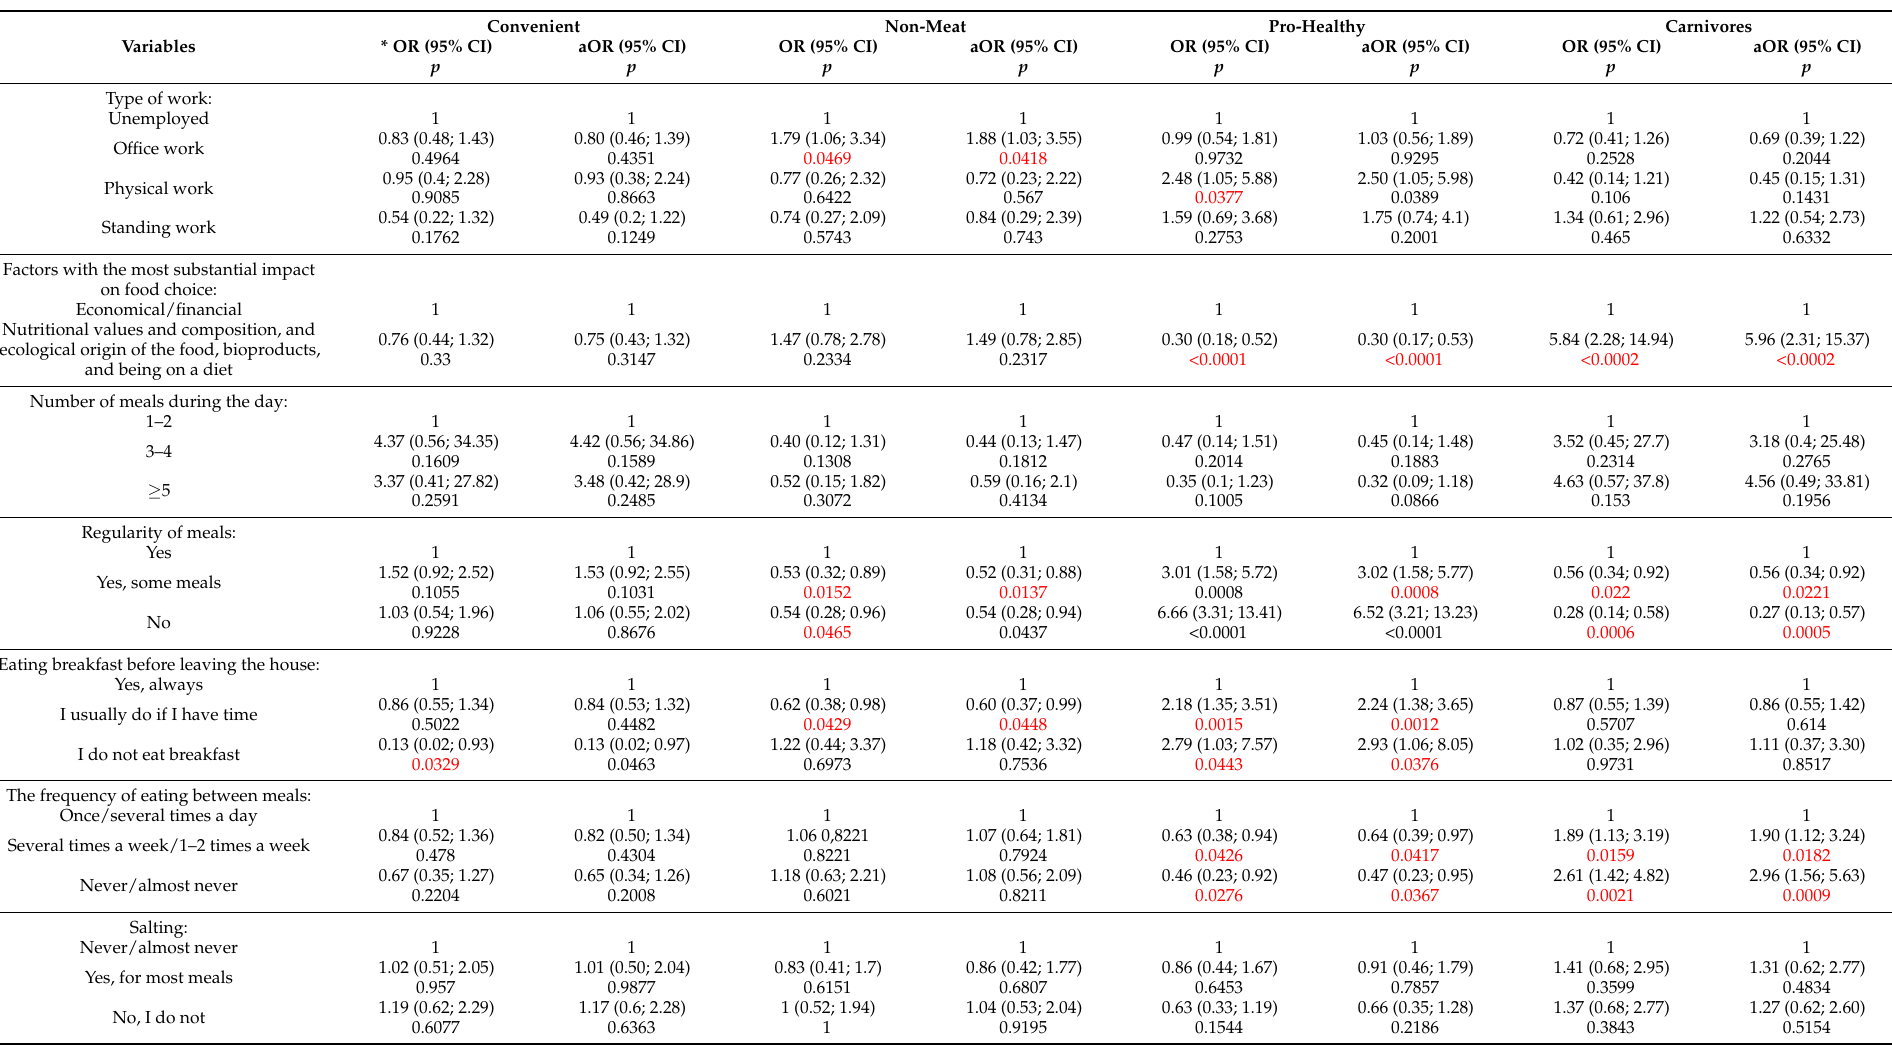
Table 6. Associations between dietary patterns and selected characteristics of the study sample (odds